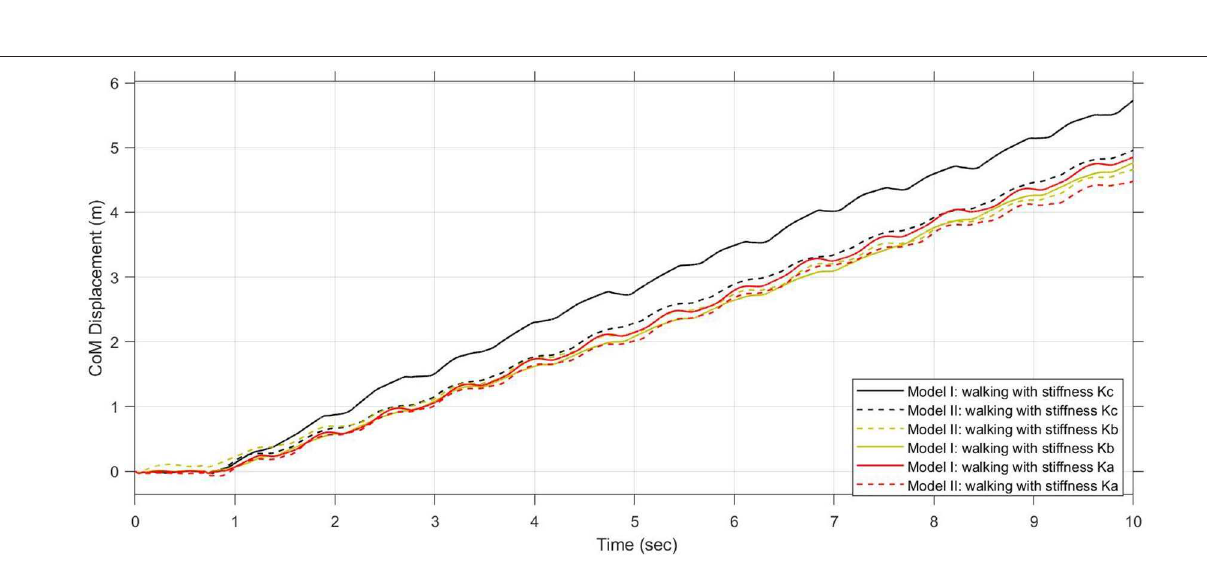
FIGURE 9 | Comparison of performances between Model I and Model II, during walking and using different stiffness value for K 1 : K a , K b , and K c